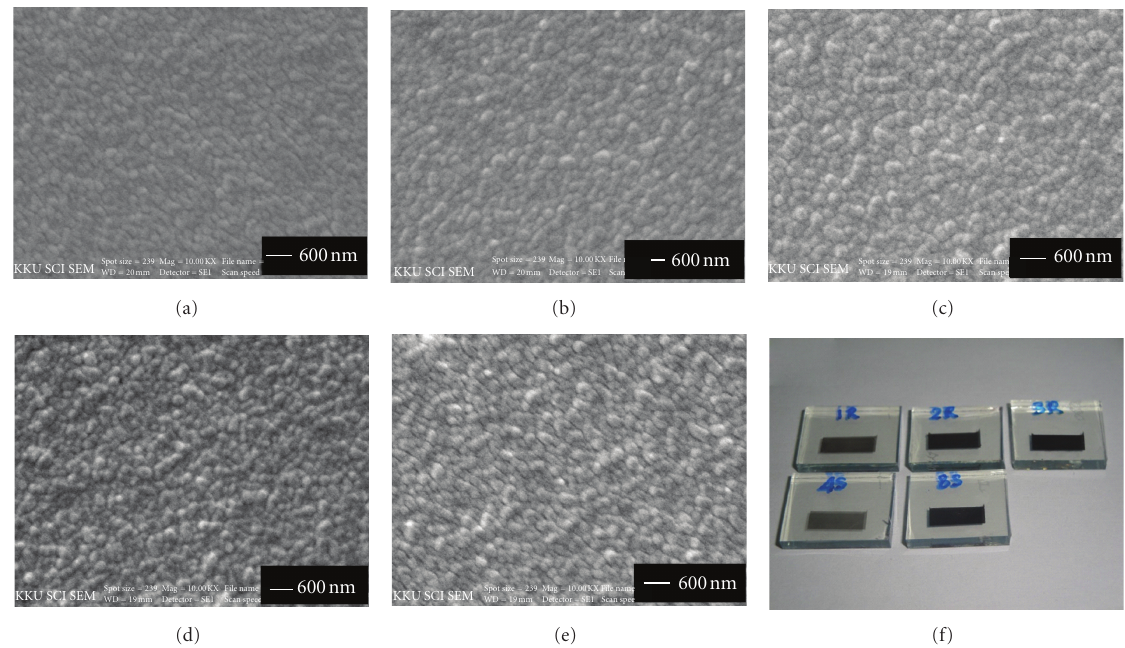
Figure 3: Top views of PPy films deposited via (a) alternate current for 1 round ( AC-1R-PPy ), (b) alternate current for 2 rounds ( AC-2R- PPy ), (c) alternate current for 3 rounds ( AC-3R-PPy ), (d) direct current for 4 s ( DC-4s-PPy ), (e) direct current for 8 s ( DC-8s-PPy ), and (f) optical image of PPy films.